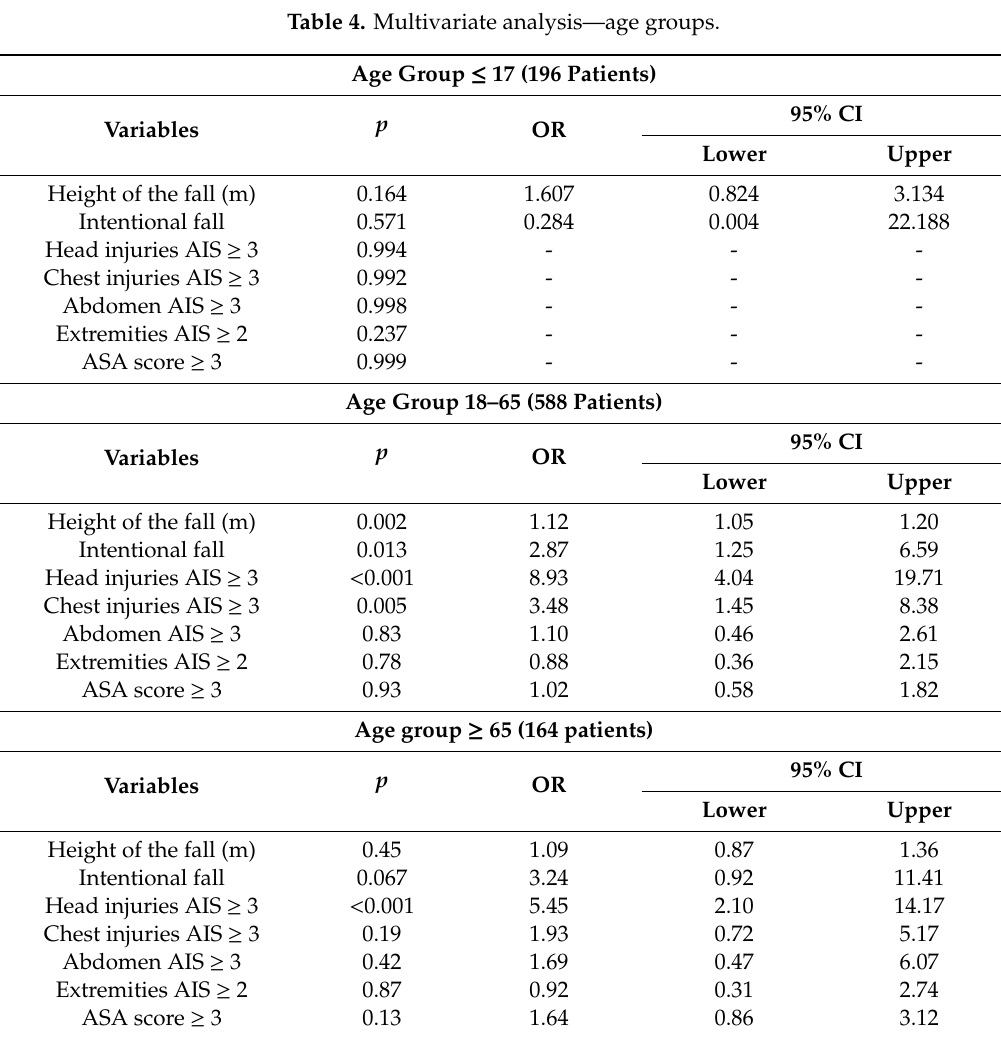
Table 4. Multivariate analysis—age